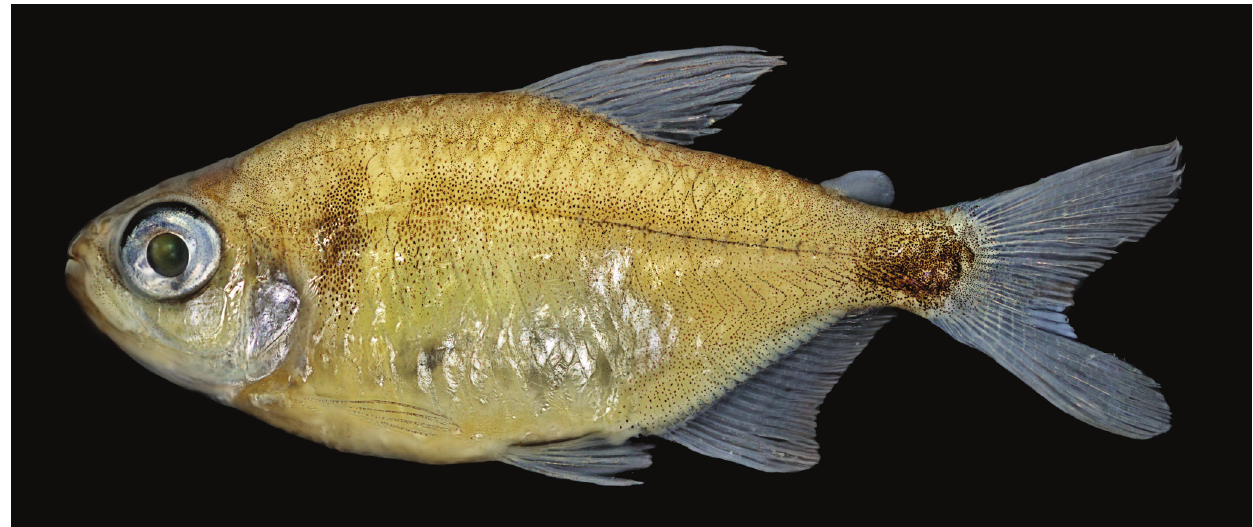
Fig. 8. Hyphessobrycon loweae , MZUSP 101404, 28.1 mm SL, female, Brazil, Mato Grosso State, rio das Mortes (rio Araguaia/ Tocantins